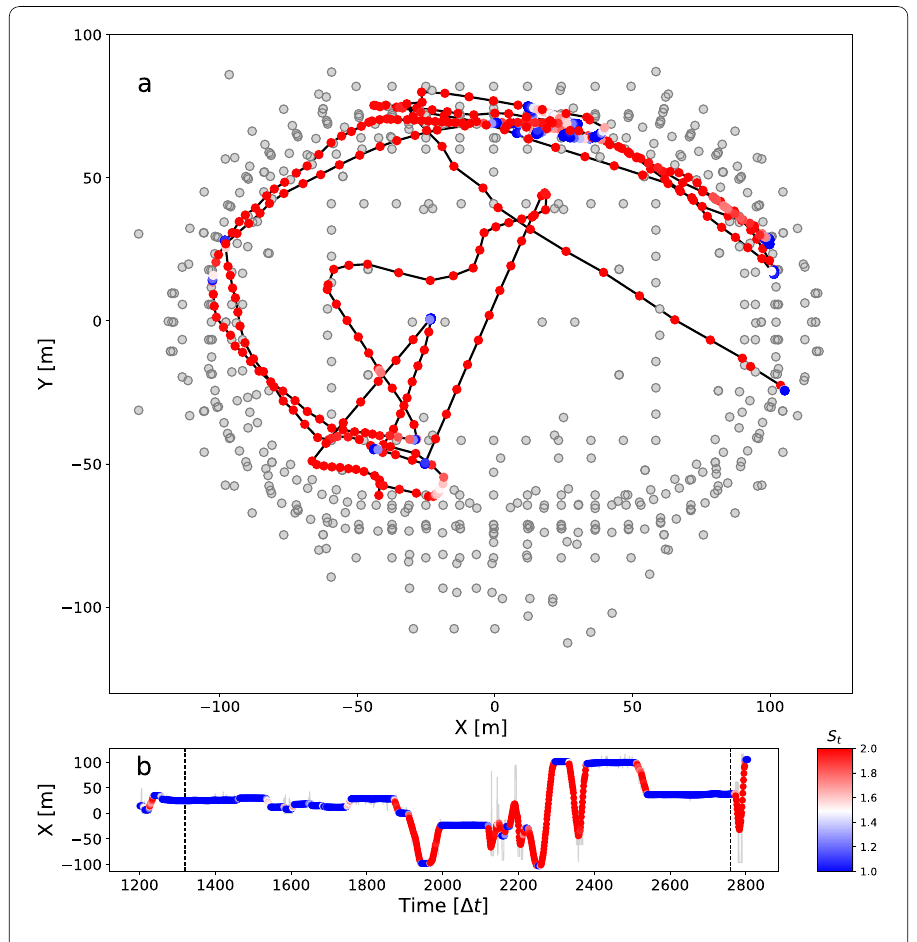
Figure 4 ( a ) Example of inferred locations and behavioural states by the CGLSSM, of an example movement track during the Armin van Buuren dance event (same as Fig. 2). Colours represent posterior means of behavioural state estimates, where red is the moving state, and blue is the non-moving state. ( b ) Inferred locations and behavioural states shown in the x -coordinate time series (unit = (cid:2) t = 10 s). Dotted vertical lines indicate start and end times of the DJ show